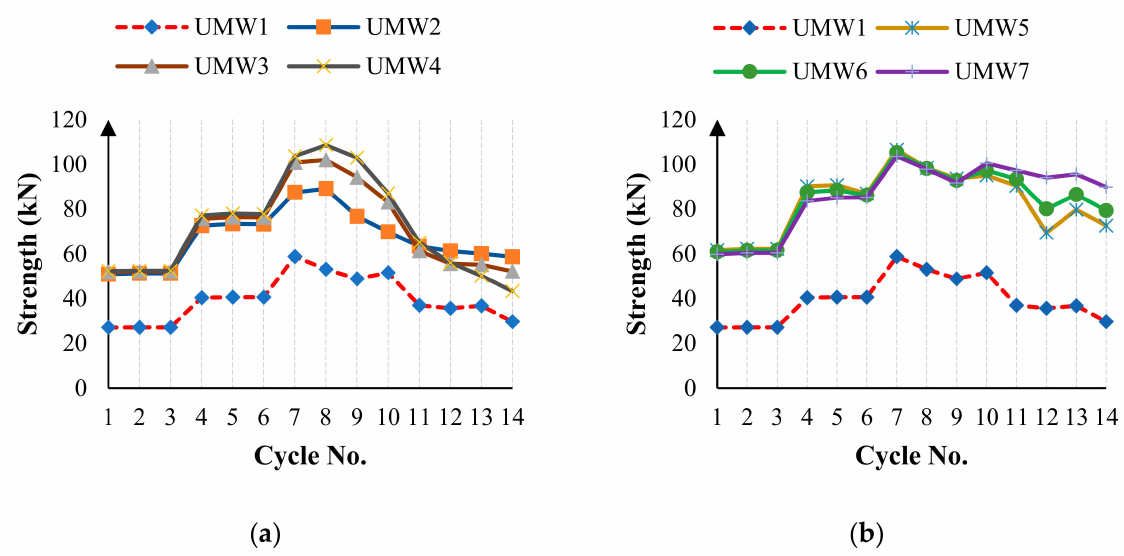
Figure 19. Maximum strength in each cycle of the loading in the positive direction ( a ) vertical-strip walls and ( b ) cross- strip